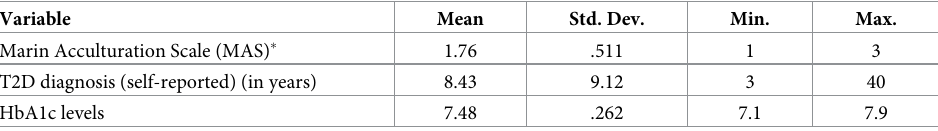
Table 1. Phase I: Summary statistics of the MAS and T2D variables (N = 15). Variable Mean Std. Dev. Min. Max. Marin Acculturation Scale (MAS) � 1.76 .511 1 3 T2D diagnosis (self-reported) (in years) 8.43 9.12 40 HbA1c levels 7.48 .262 7.1 7.9 � Lower scores = lower acculturation; scores ranged from 1 = only Spanish, 2 = more Spanish than English, 3 = both equally, 4 = English better than Spanish, and 5 = only English. T2D (type 2